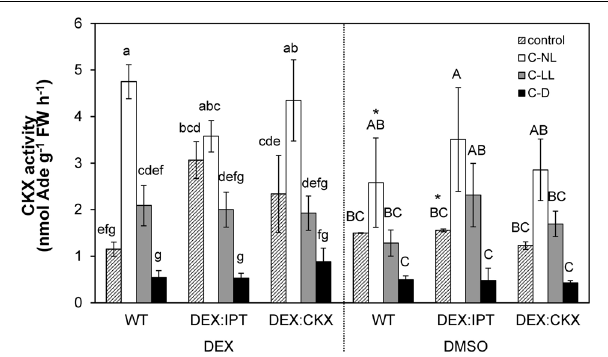
FIGURE 5 | The activity of cytokinin oxidase/dehydrogenase (CKX) enzyme in leaves of WT, DEX:IPT , and DEX:CKX plants exposed to cold treatments under different light conditions. Plants were activated by dexamethasone diluted in DMSO (DEX) or treated by pure DMSO. See Table 1 for the description of experimental variants and Figure 1 for statistics (n =